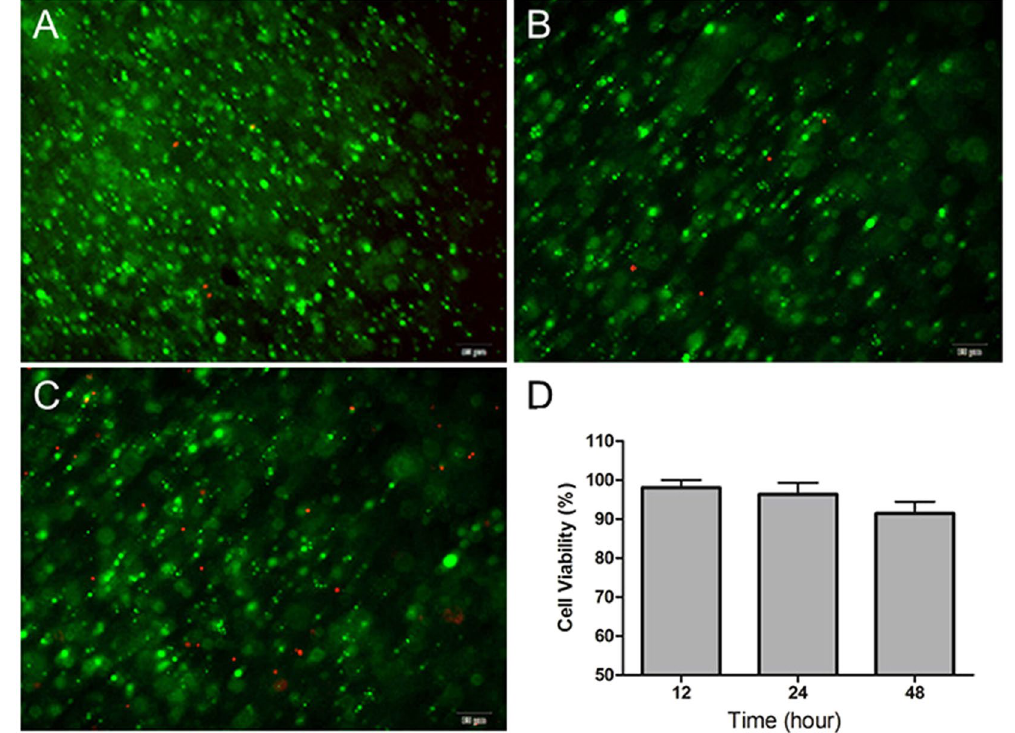
Figure 2. In vitro cytocompatibility of CS/HA hydrogel. Live/Dead staining of the encapsulated L929 fibroblasts for 12 h ( A ), 24 h ( B ), and 48 h ( C ). ( D ) The cell viability at different culture